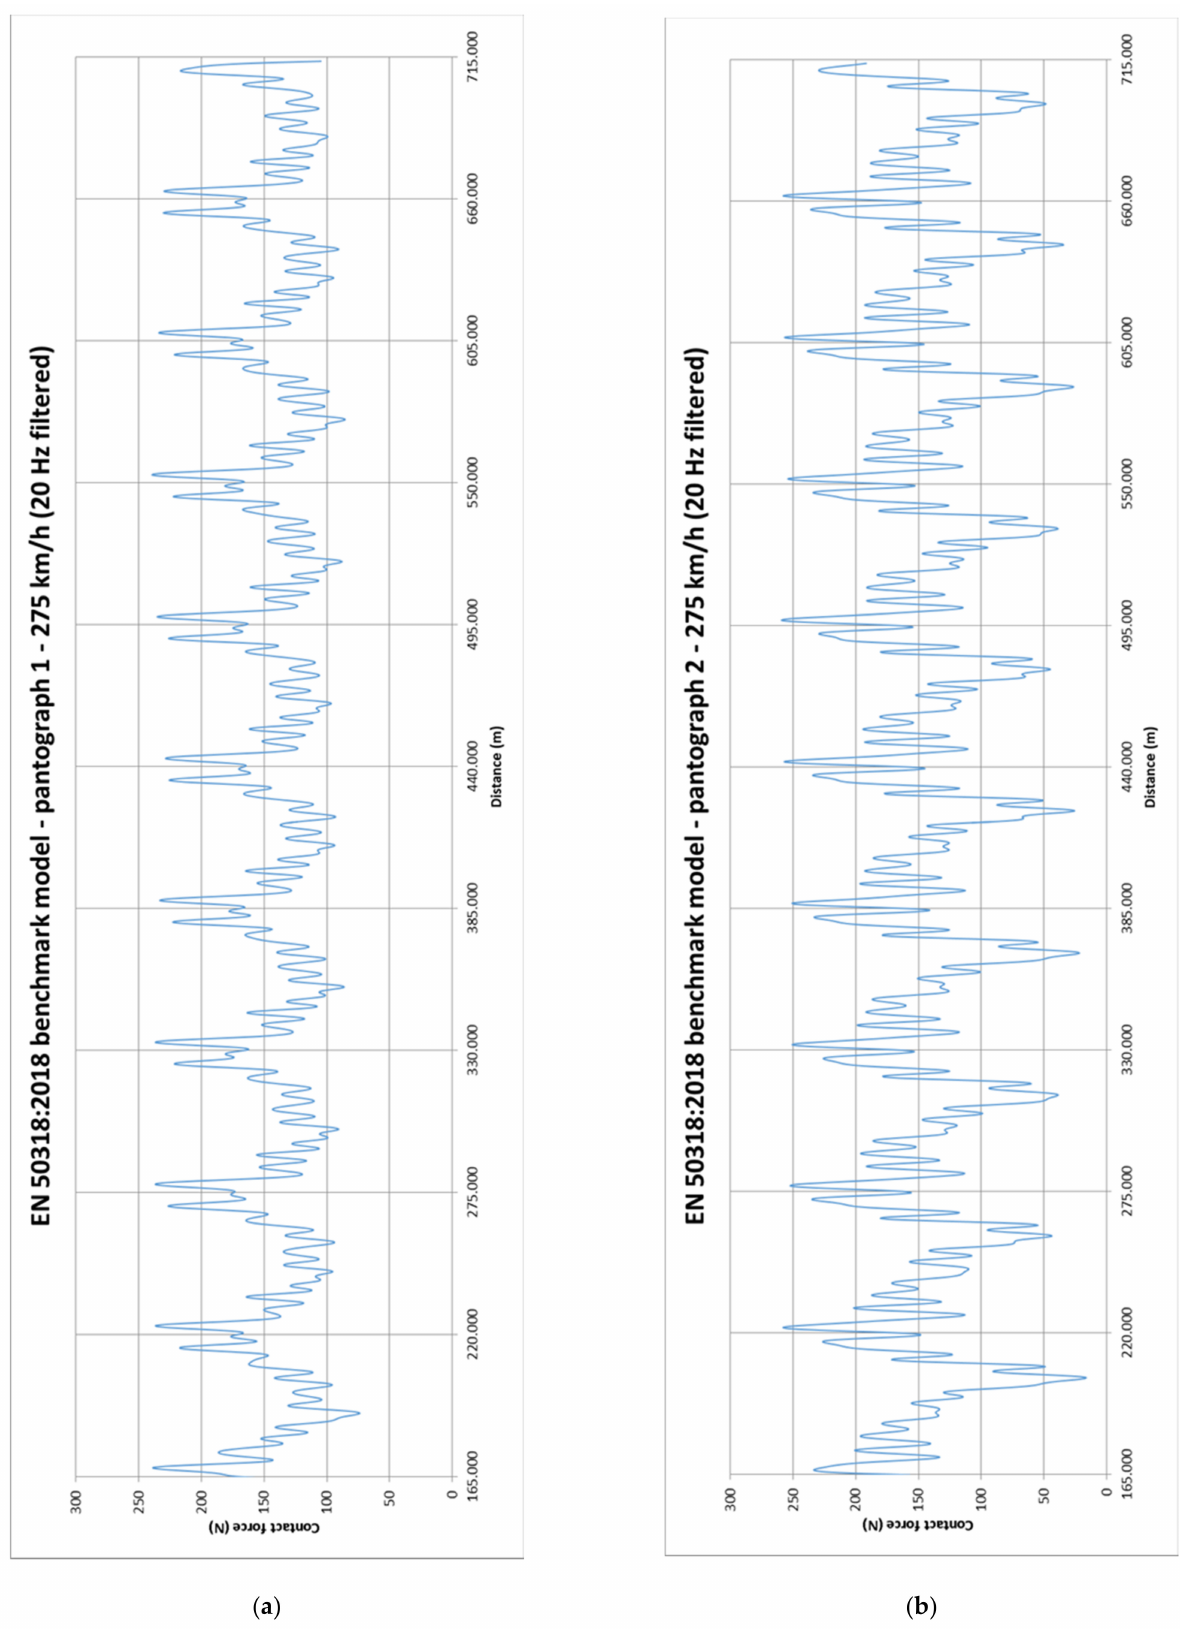
Figure 15. EN 50318:2018 benchmark model simulated contact force at 275 km/h (20 Hz filtered) for ( a ) pantograph 1 (leading) and ( b ) pantograph 2